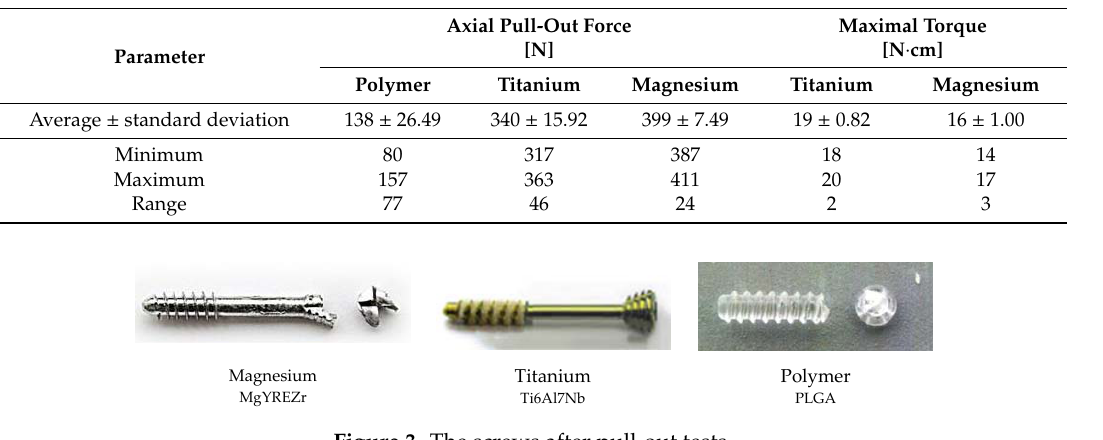
Figure 3. The screws after pull ‐ out tests.